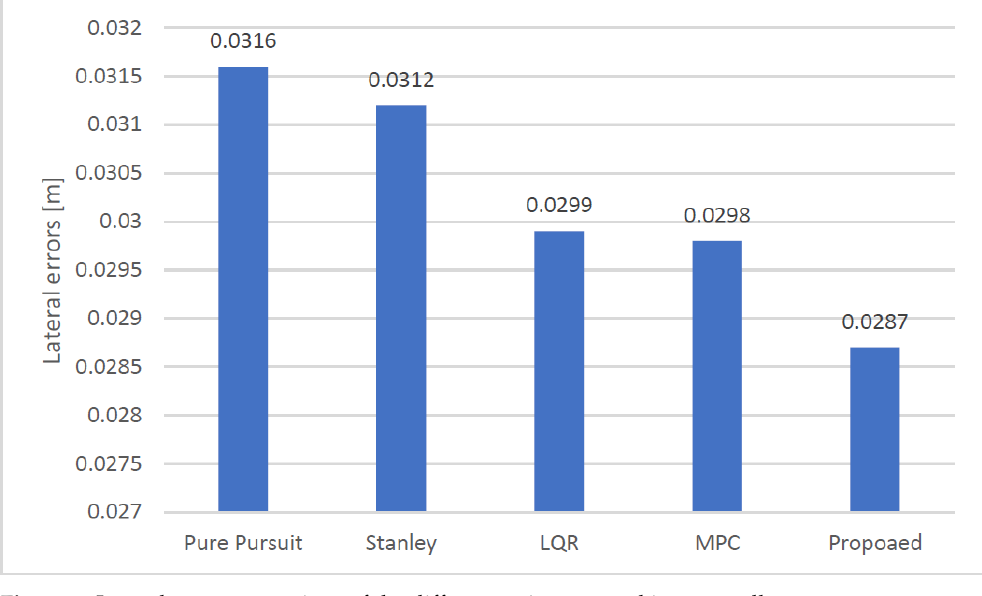
Figure 9. Lateral error comparison of the different trajectory tracking controllers. Table 2. Error comparison at every curve of the simulated trajectory. Results are presented in